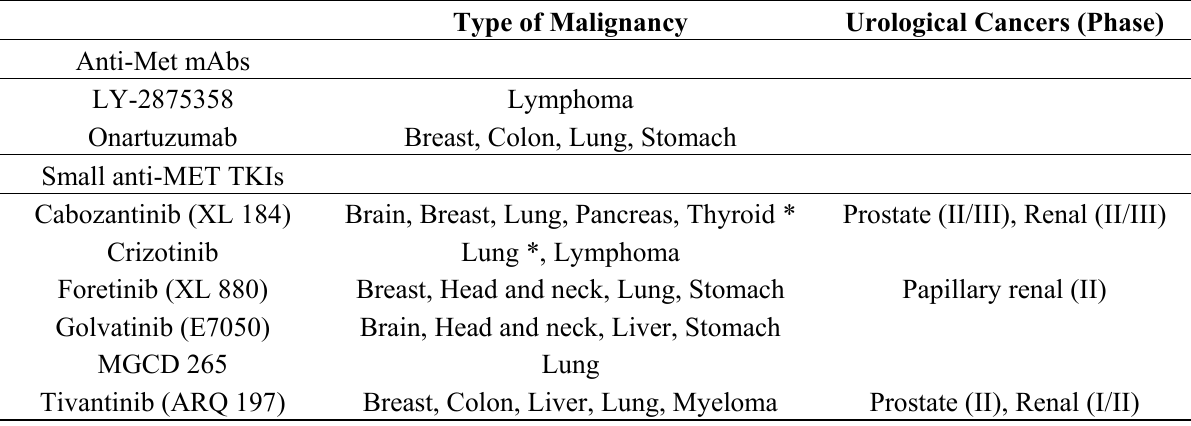
Table 1. Met-targeting therapies for malignancies including urological